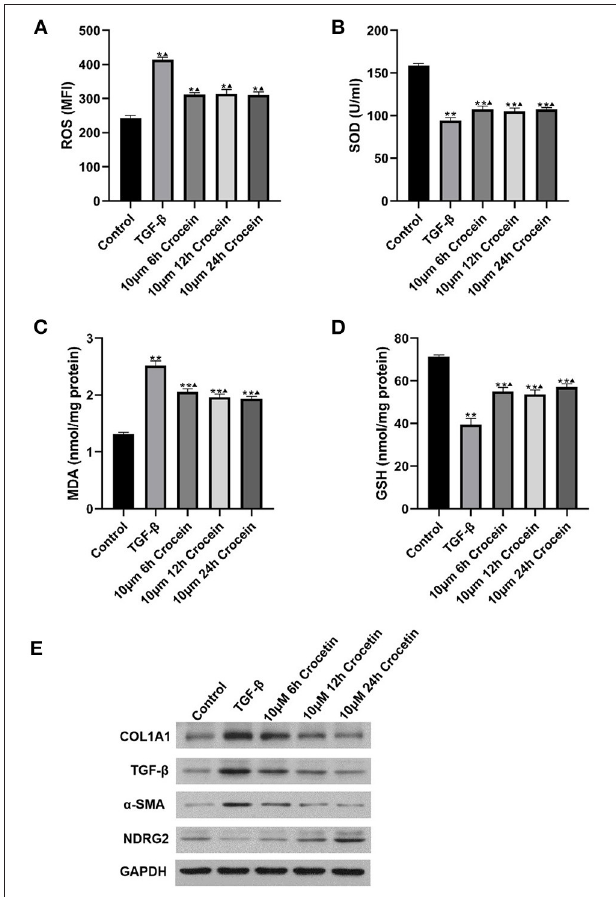
FIGURE 2 | LO2 cells were incubated with 10 µ M of crocetin for 6, 12, and 24h, respectively, and then induced by 2ng/ml of TGF- β . (A–D) Comparisons on ROS, SOD, MDA, and GSH levels among the groups with or without crocetin pre-treatment and/or TGF- β induction. (E) Expressions of COL1A1, TGF- β , α -SMA, and NDRG2 in LO2 cells were measured by western blot. *Comparing to the Control, P < 0.05. ** Comparing to the Control, P < 0.01. N Compared to TGF- β , P <